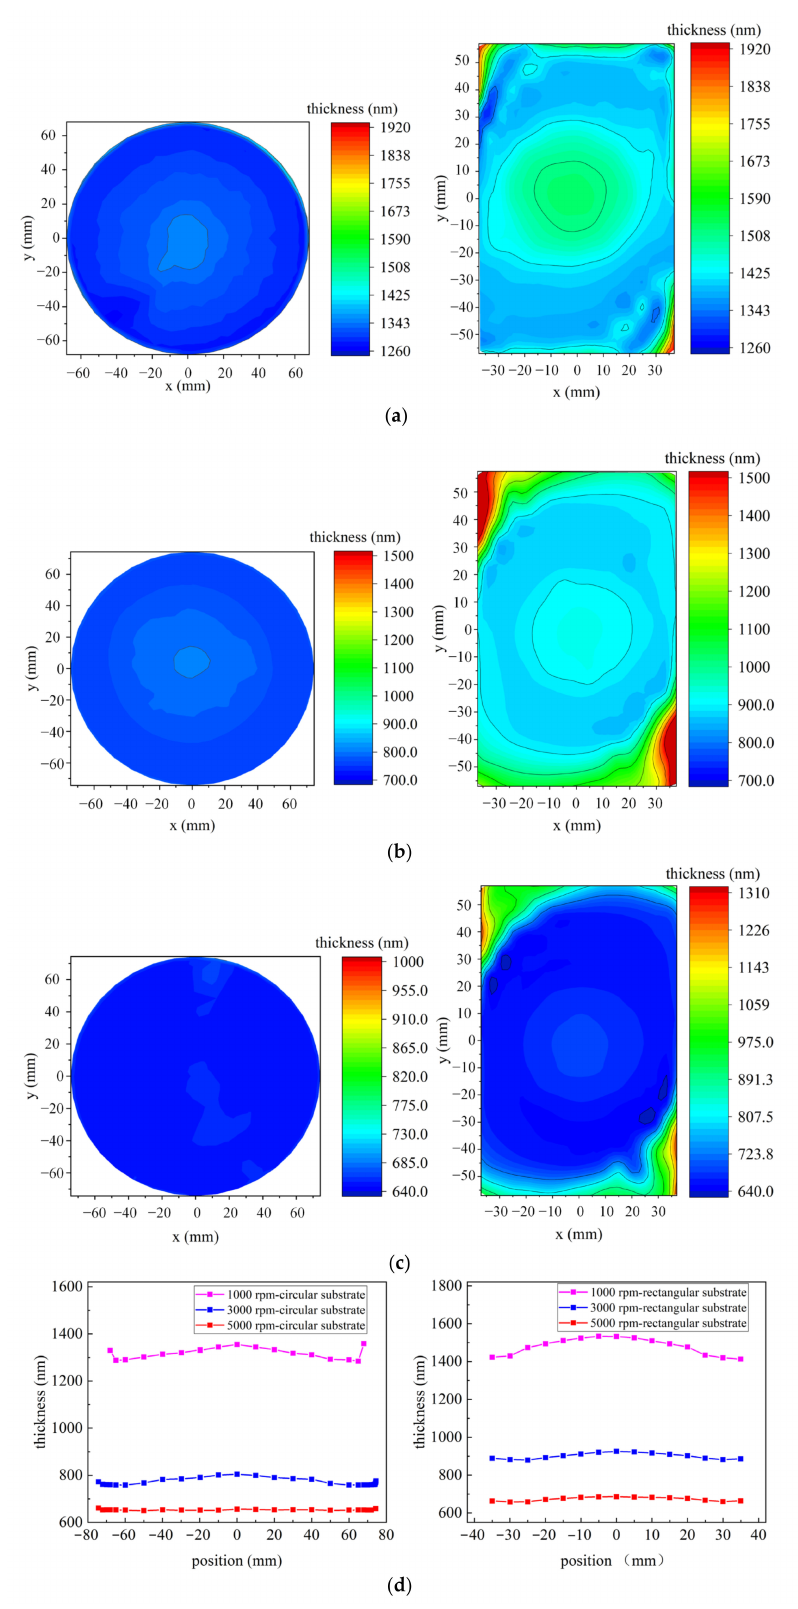
Figure 9. Film thickness distribution on rectangular and circular substrates: ( a ) Film thickness distribution at 1000 rpm; ( b ) Film thickness distribution at 3000 rpm; ( c ) Film thickness distribution at 5000 rpm; ( d ) Film thickness curve of circular (left) and rectangular (right) substrate at y =